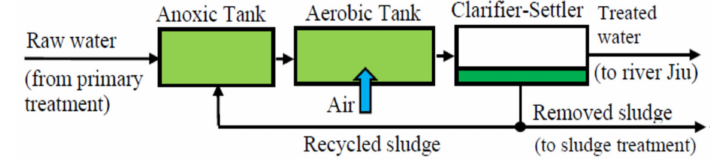
Figure 3. The ASP structure—WWTP F ă c ă i